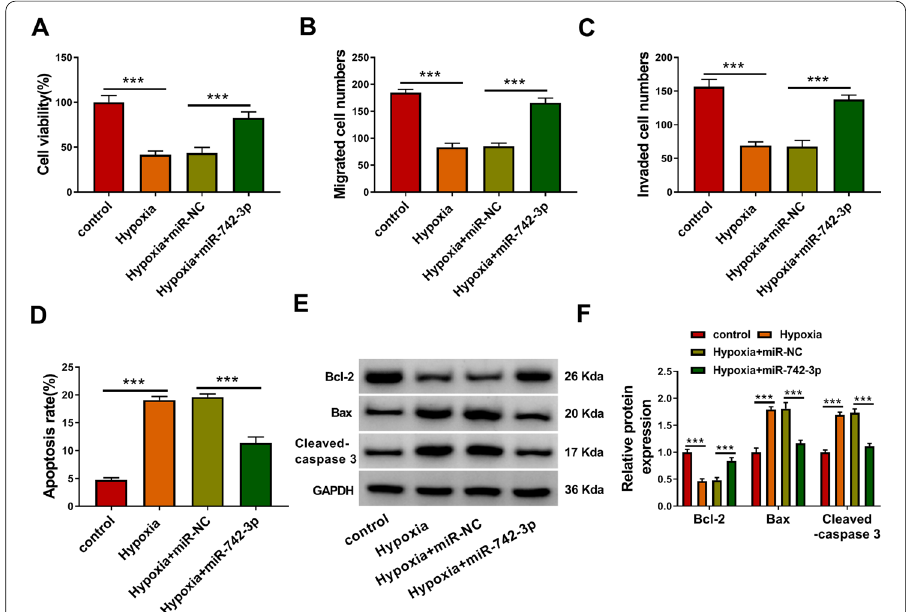
Fig. 4 MiR-742-3p relieved hypoxia-induced H9c2 cell injury. H9c2 cells were transfected with or without miR-NC (50 nM) or miR-742-3p mimic (50 nM), and then treated with hypoxia. Untreated H9c2 cells were used as control. Cell viability, migrated and invaded cell numbers, and cell apoptosis rate were measured using CCK8 assay ( A ), transwell assay ( B , C ) and flow cytometry ( D ). E , F The protein levels of Bcl-2, Bax and Cleaved-caspase 3 were determined using WB analysis. All experiments were repeated three times. *** P <